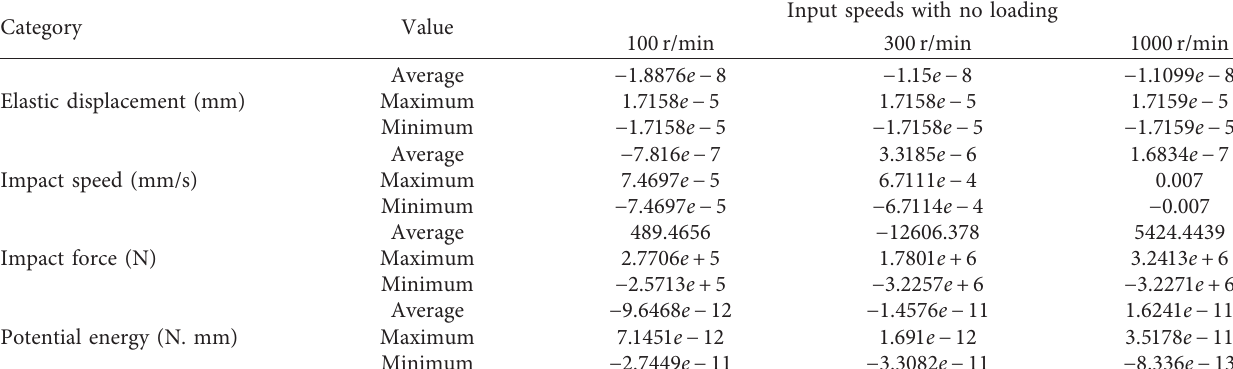
Table 3: Impact characteristics of third-stage face gear pair without load.